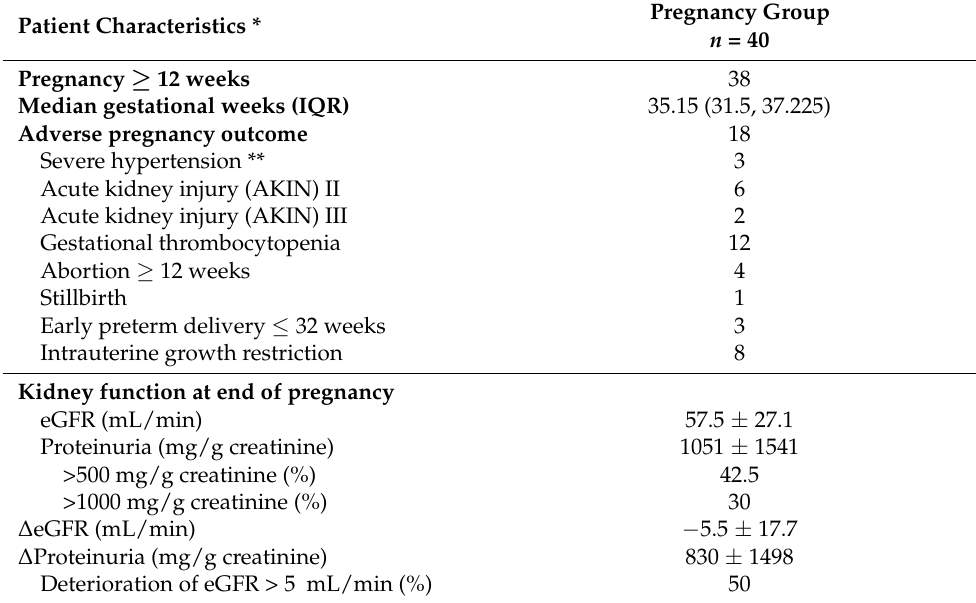
Table 2. Pregnancy and allograft outcomes in post-transplant